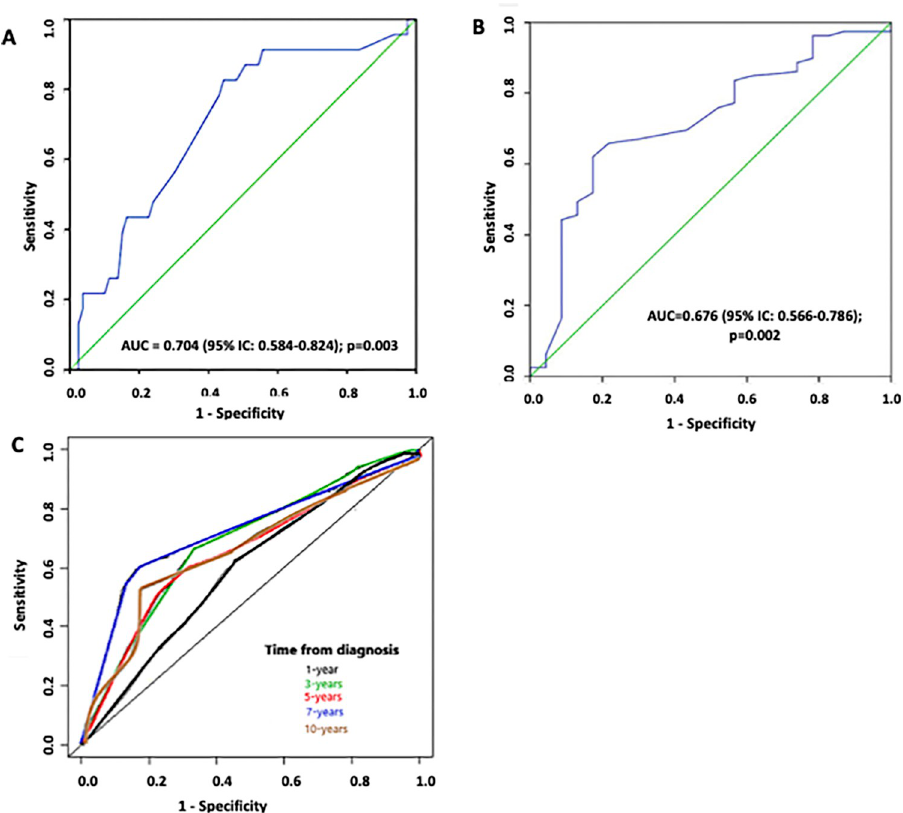
Fig 1. Prognosis accuracy of the HRR1 admission value (cut-off point = 17 beats) for predicting clinical worsening in PAH. (A) Receiver operator characteristic (ROC) curve of heart rate recovery in 1 minute (HRR1) after the end of six-minute walk test in all pulmonary arterial hypertension (PAH) patients enrolled in the study. (B) ROC curve representing the internal validation model by bootstrap. (C) Time-dependent ROC curves representing the prognostic accuracy of the HRR1 admission for predicting of the composite outcome at 1-, 3-, 5-, 7- and 10-years.